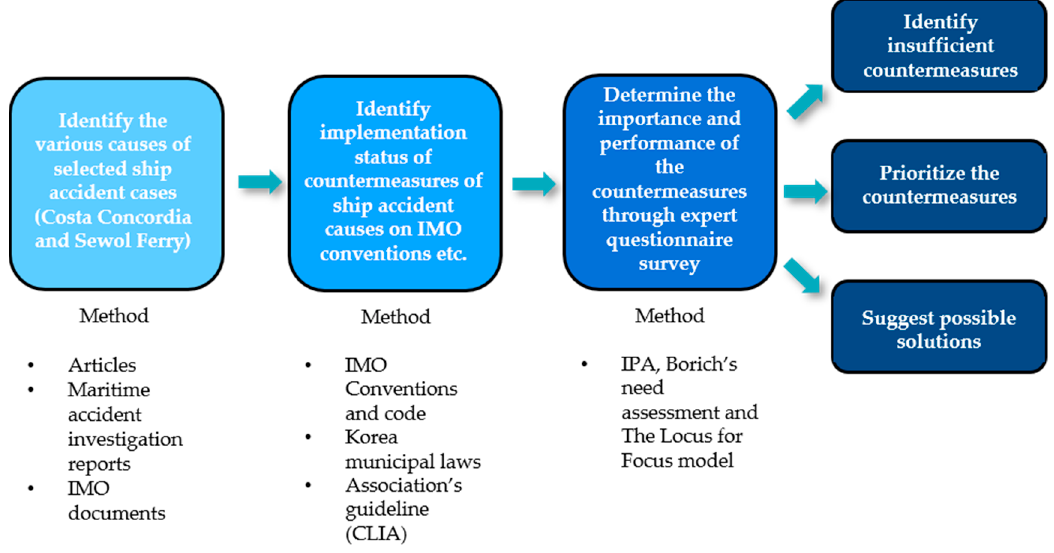
Figure 1. Procedure and methods performed in this study. IPA, importance–performance analysis.